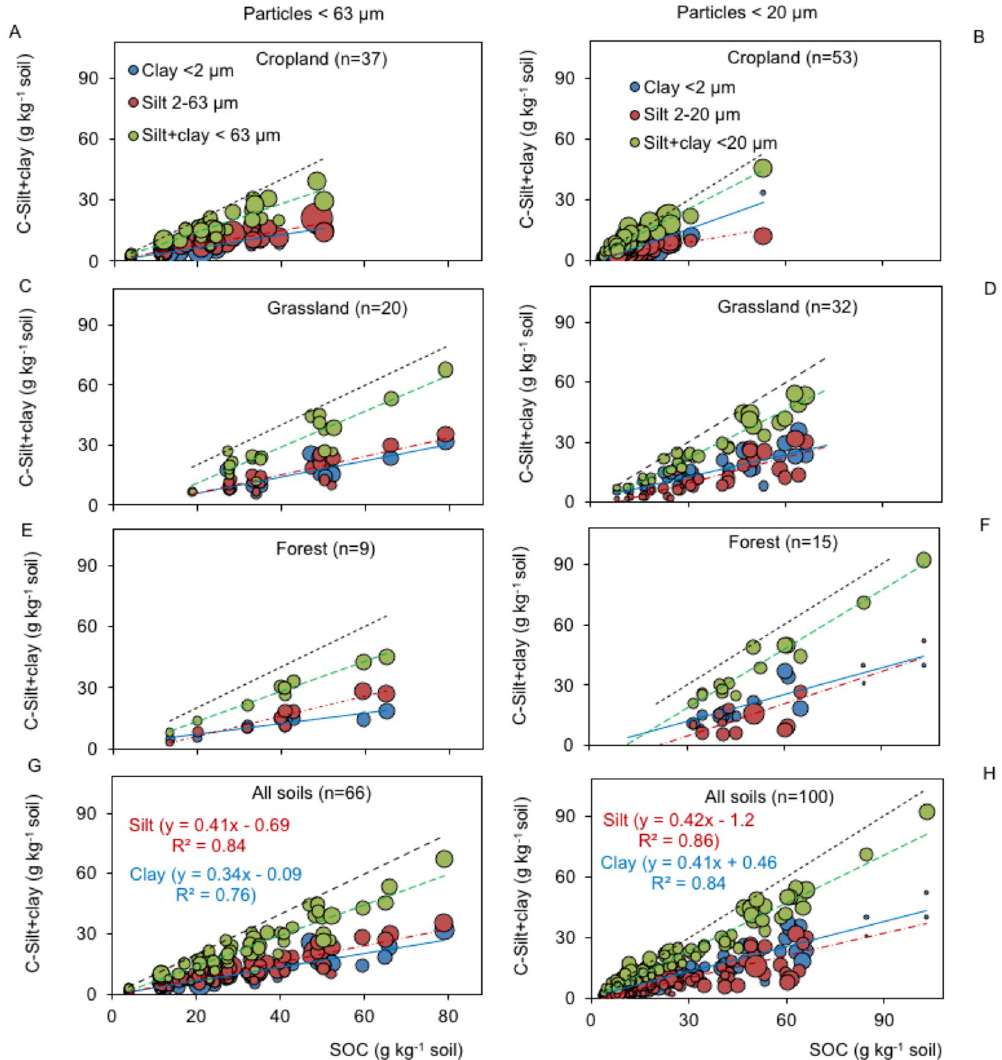
Figure 5. Relationship between soil organic carbon (SOC) content and C in silt or clay particles for < 63 µm ( A , C , E , G ) and < 20 µm ( B , D , F , H ). The greater bubble size indicates high weight with lower standard errors. Long segmented line stands for 1:1. Short segmented or solid line stands for regression fitting to clay, silt or silr + clay